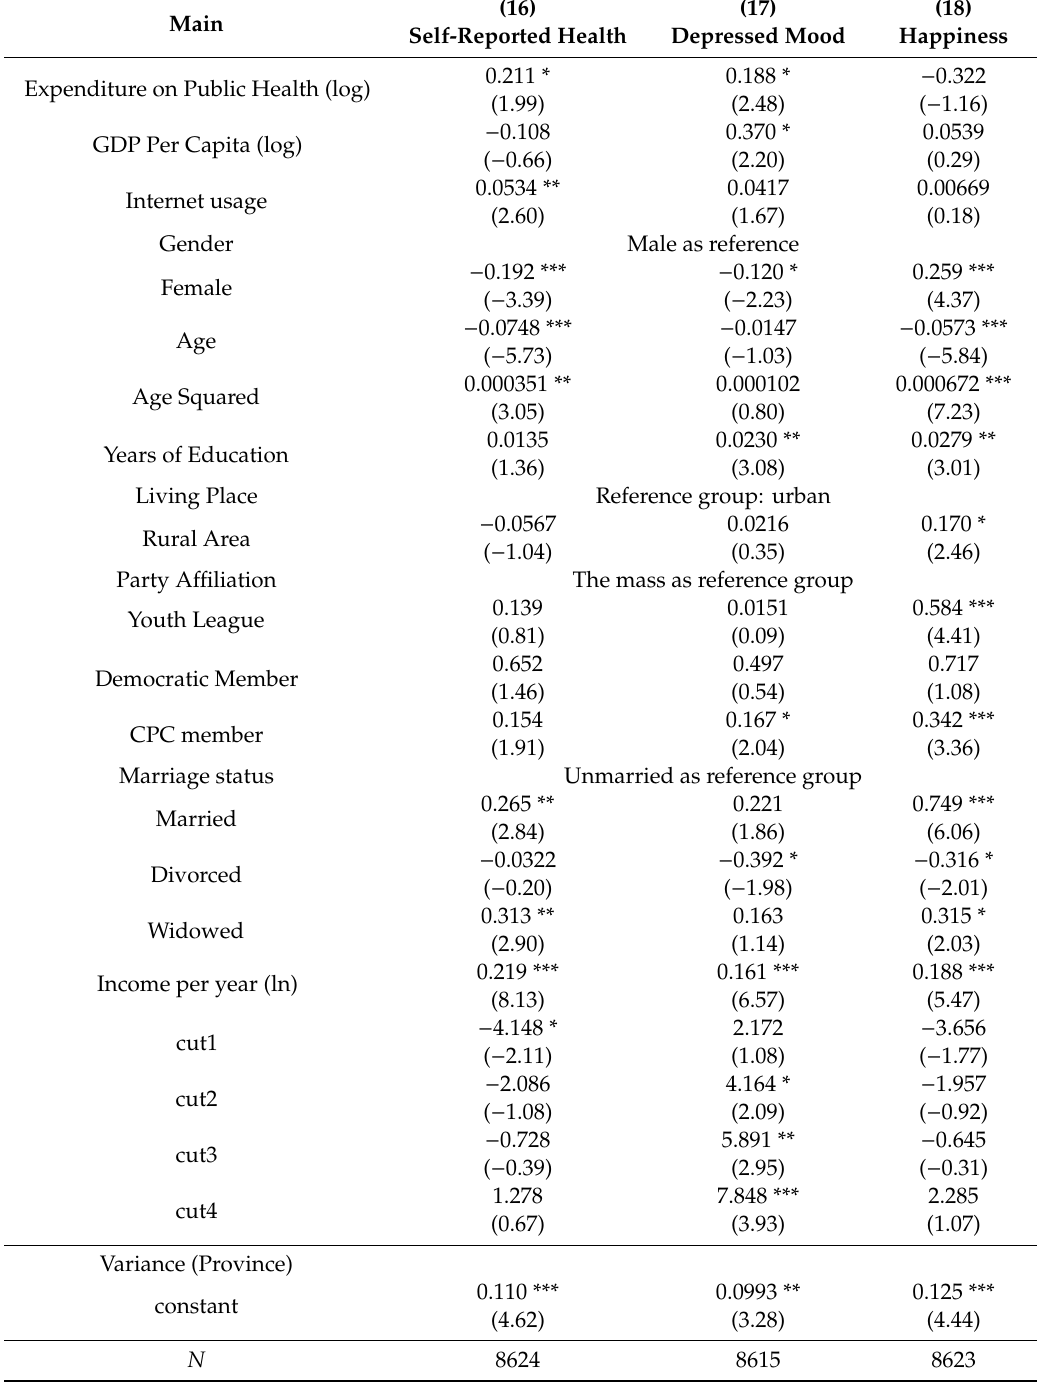
Table 5. Multi-level ordered logit model with